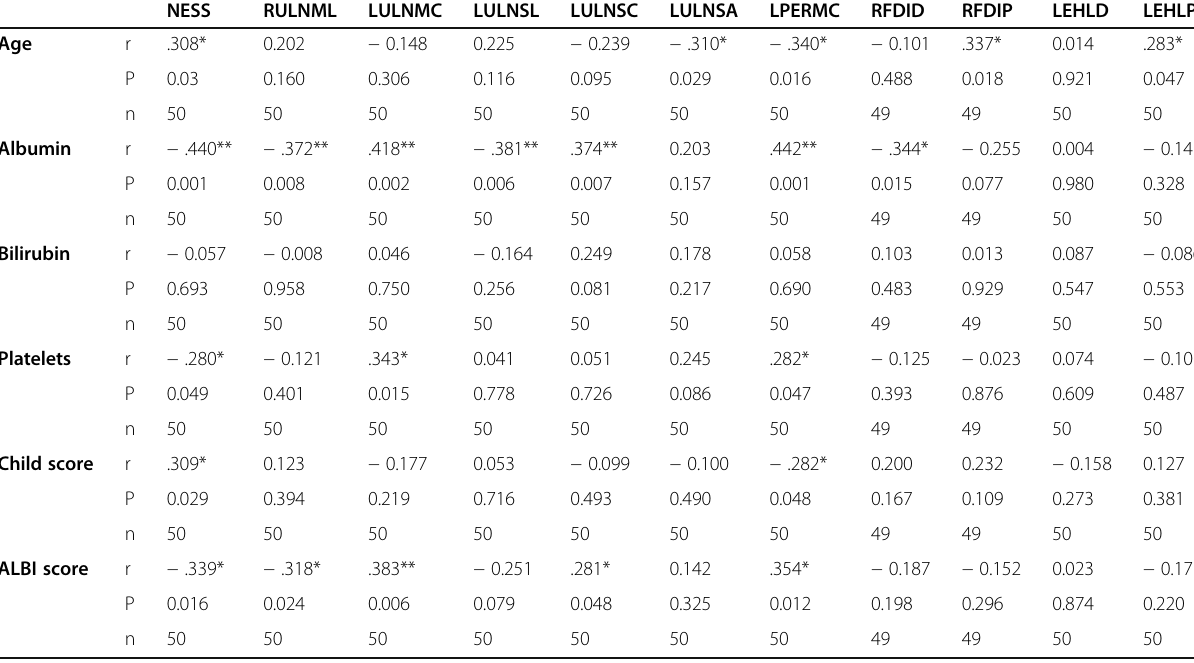
NESS , neuropathy electrodiagnostic severity score; RULNML , right ulnar motor latency; LULNMC , left ulnar motor conduction velocity; LULNSL , left ulnar sensory latency; LULNSC , left ulnar sensory conduction velocity; LULNSA , left ulnar sensory amplitude; LPERMC , left peroneal motor conduction velocity; RFDID , right first dorsal interosseous duration, RFDIP , right first dorsal interosseous phases; LEHLD , left extensor hallucis longus duration; LEHLP , left extensor hallucis longus phases; ALT , alanine transaminase; AST , aspartate; INR , international normalized ratio; BMI , body mass index; NSC , neuropathy symptom and change; ALBI , albumin- bilirubin; r , correlation coefficient * Correlation is significant at the 0.05 level, ** Correlation is significant at the 0.01